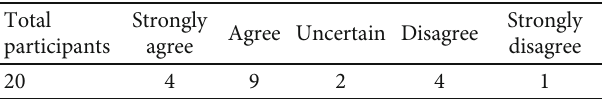
Table 3: Experiment result